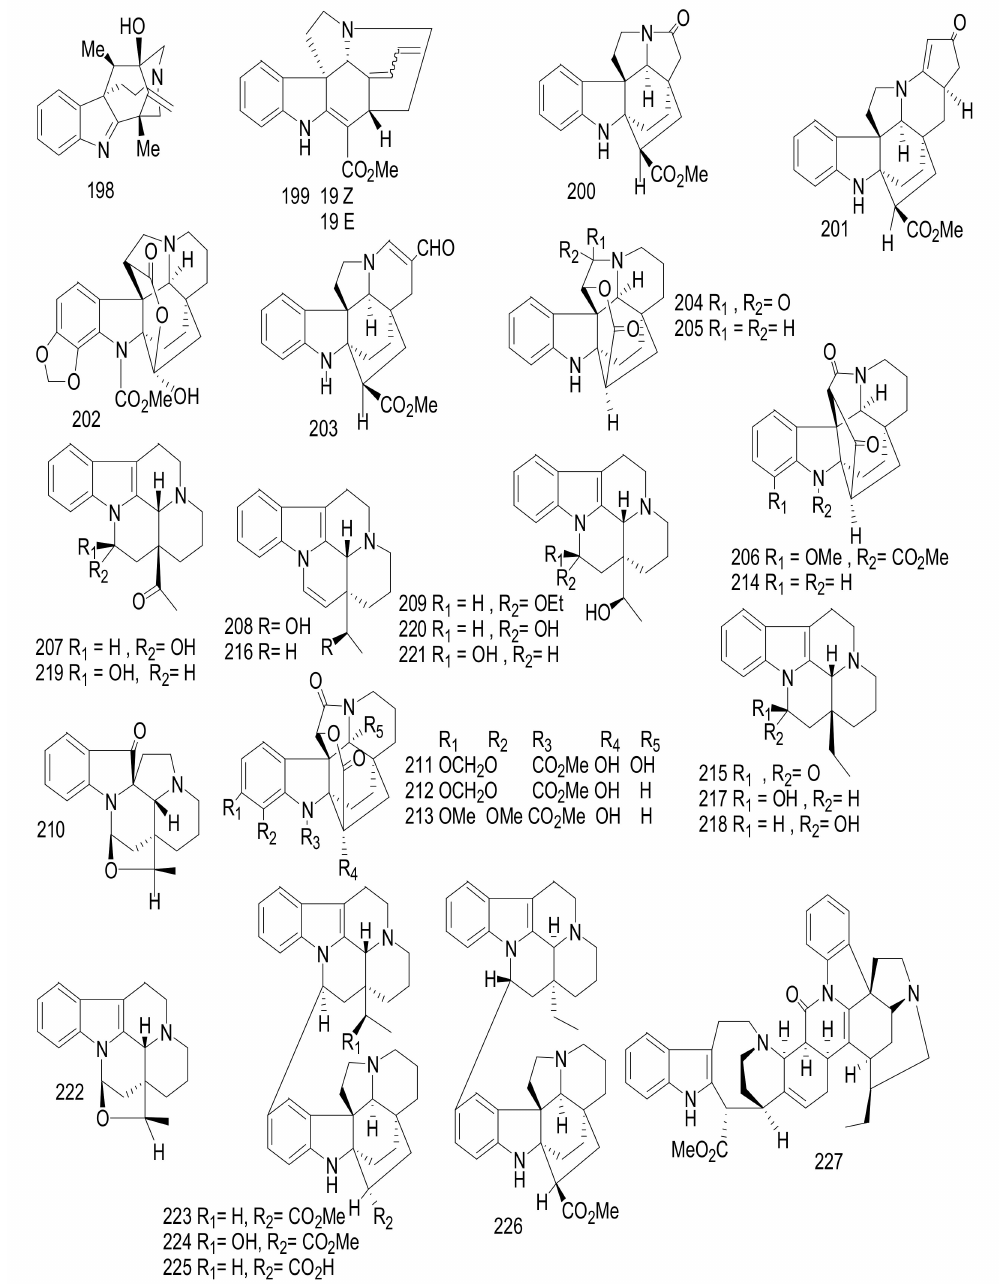
Figure 20. Compounds 198 – 227 . Seven aspidofractinine -type alkaloids, paucidirinine ( 200 ), paucidirisine ( 201 ), pauci- dactinine ( 202 ), pauciduridine ( 203 ), paucidactine D ( 204 ), paucidactine E ( 205 ), and pau- cidisine ( 206 ), along with Additionally, four eburnane skeleton, ( − )-19-oxoisoeburnamine ( 207 ), ( − )-19( R )-hydroxyeburnamenine ( 208 ), ( − )-19( R )-hydroxy- O -ethylisoeburnamine ( 209 ), and larutienine B ( 210 ) were isolated from Kopsia pauciflora [91]. Moreover, twelve com- pounds, paucidactine A ( 211 ), paucidactine B ( 212 ) [105], paucidactine C ( 213 ) [88], 5, 22- dioxokopsane ( 214 ) [98], (+)-eburnamonine ( 215 ) [94], (+)-eburnamenine ( 216 ) [106], ( − )- eburnamine ( 217 ), (+)-isoeburnamine ( 218 ) [94], (+)-19-oxoeburnamine ( 219 ) [105], ( − )-19( R )- hydroxyisoeburnamine ( 220 ), (+)-19( R )-hydroxyeburnamine ( 221 ) [87], and larutienine A ( 222 ) [90] were published. Furthermore, three bisindole compounds have been identified, ( − )- norpleiomutine ( 223 ), (+)-kopsoffinol ( 224 ) [107], and ( − )-demethylnorpleiomutine ( 225 )